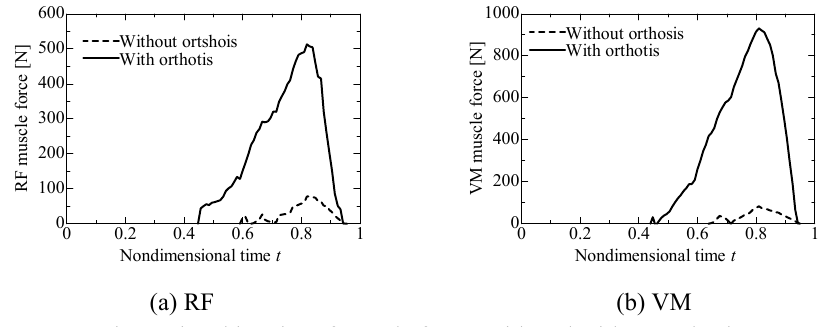
Fig. 6 Time histories of muscle forces with and without